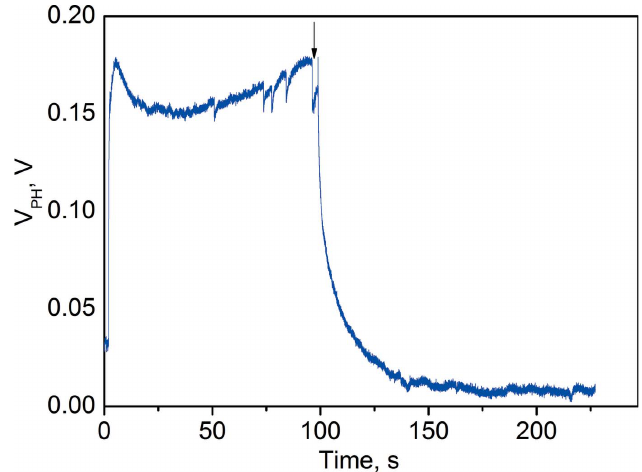
Figure 6 Time dependence of V PH of a thin film sample of (I) with a free film surface upon illumination with a white LED ( I = 40 W m (cid:5) 2 ) from the side of a transparent ITO electrode; illumination stopped at the point shown by the vertical arrow.